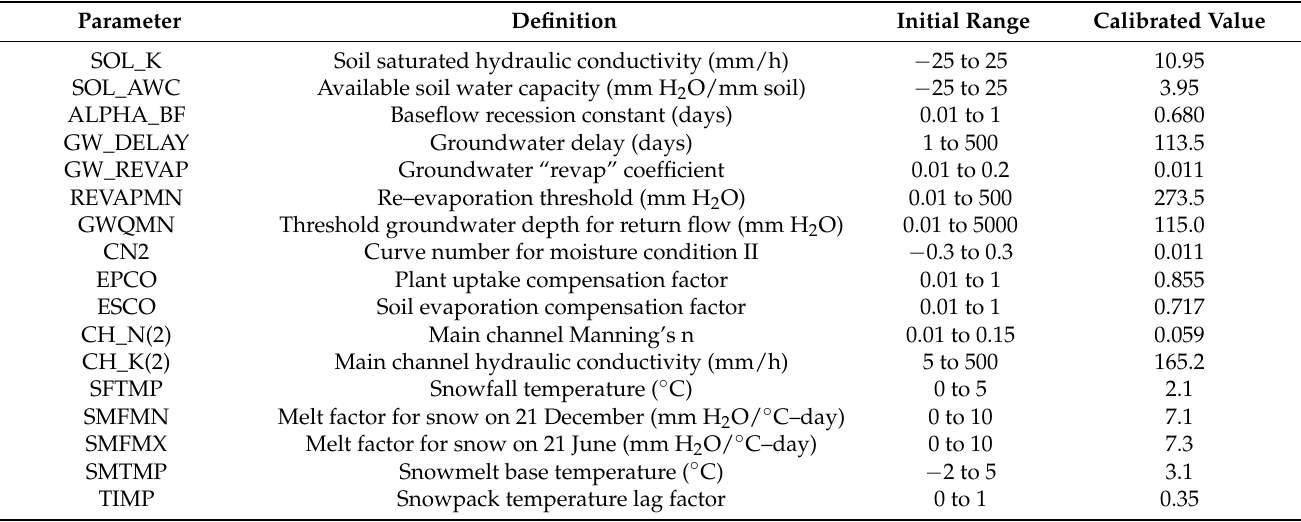
Table 2. List of model parameters used in this study to calibrate and validate the SWAT model. The model parameter names and their definitions are listed according to SWAT input/output documentation